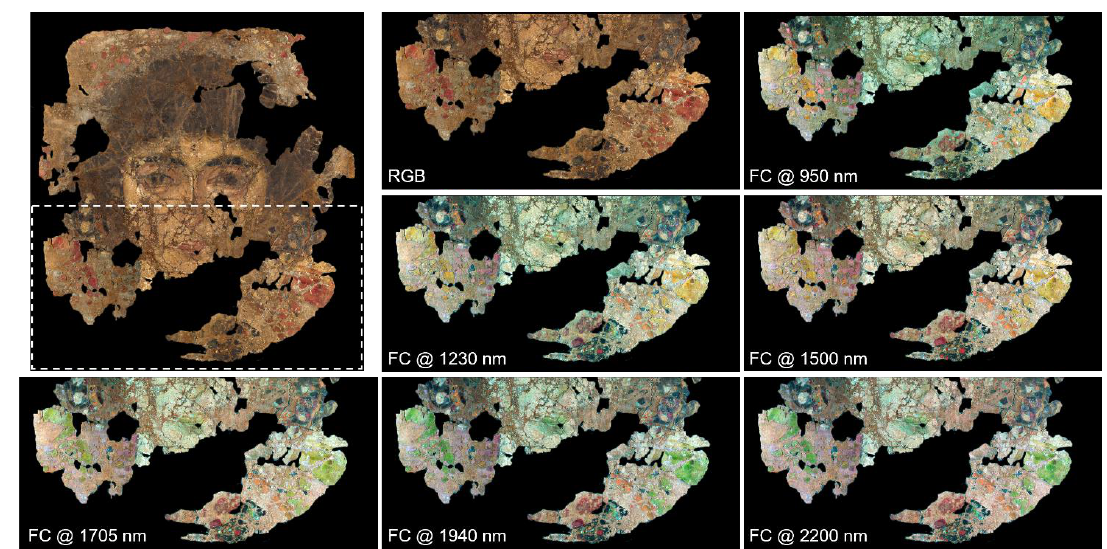
Figure 2. Colour image of the Fayum mummy portrait highlighting the area (dashed white rectangle) showed in the false colour NRG images at different wavelengths.